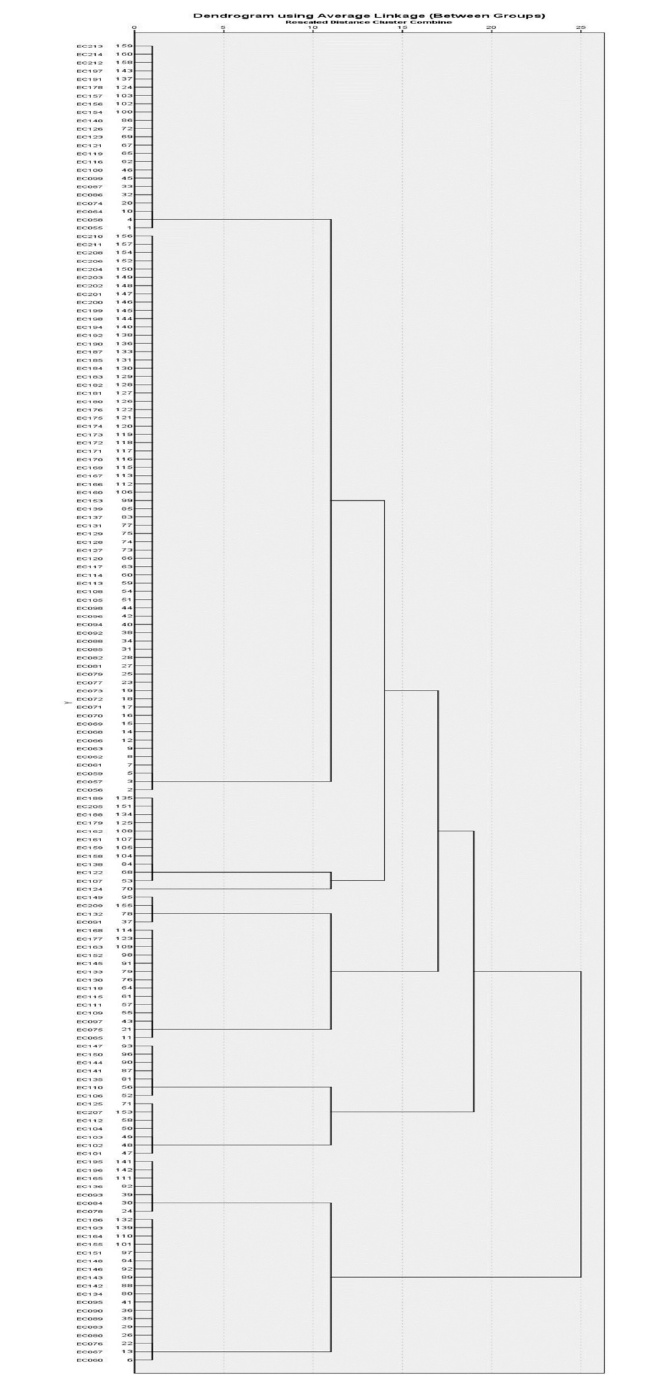
Fig 3. Hierarchical clustering of E . coli isolates according to the presence of toxin functional virulence genes ( cnf , sat , hlyA and usp